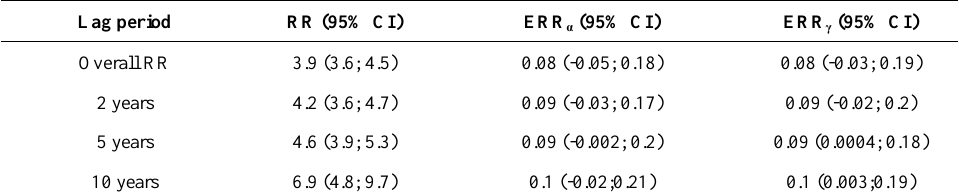
Table 4. RR estimates depending on lag period and ERR/Gy for external gamma radiation (ERRγ) and internal alpha radiation